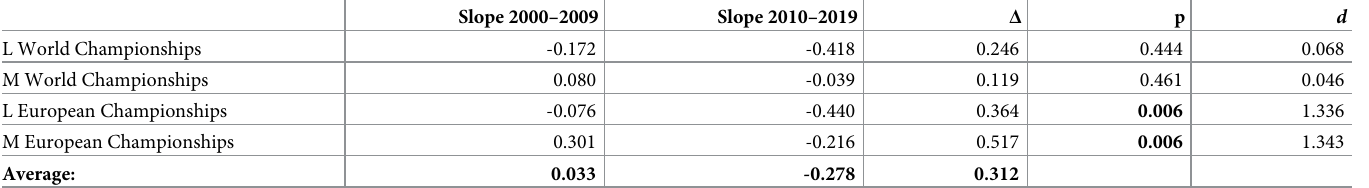
Table 1. Regression slopes of the average age (in years of age per year), the difference ( Δ ), p-values (one-sided Student’s T-Test), and effect size ( d